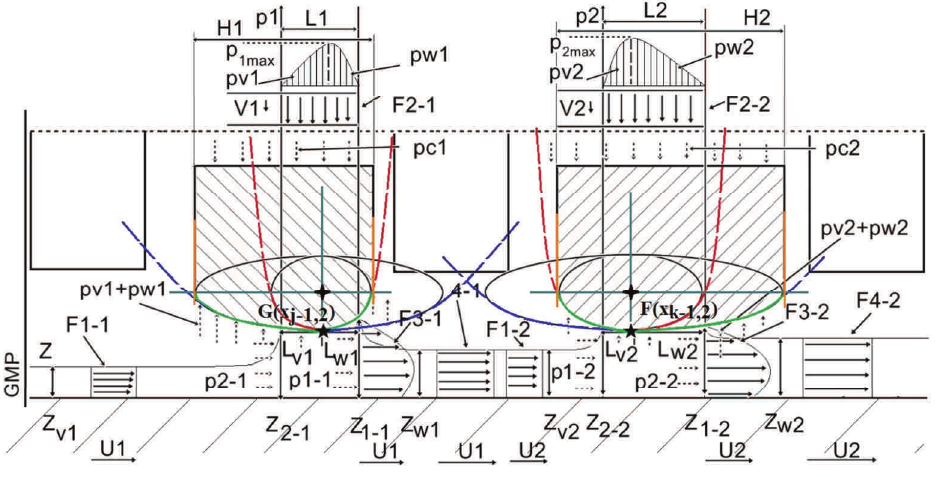
Fig. 1. Schematic representation of asymmetric geometry of parabolic and elliptical sliding surfaces, as well as velocity and pressure fields at the starting and separating points of the oil film for the lower and upper sealing rings where: – vertex coordinates of the parabolas and ellipses defining the W (cid:2),(cid:4) (cid:6)(cid:7)(cid:8) given asymmetric shape of the sliding surface, ♦ – coordinates of the ellipses common center, green line – function expressing the asymmetrical shape